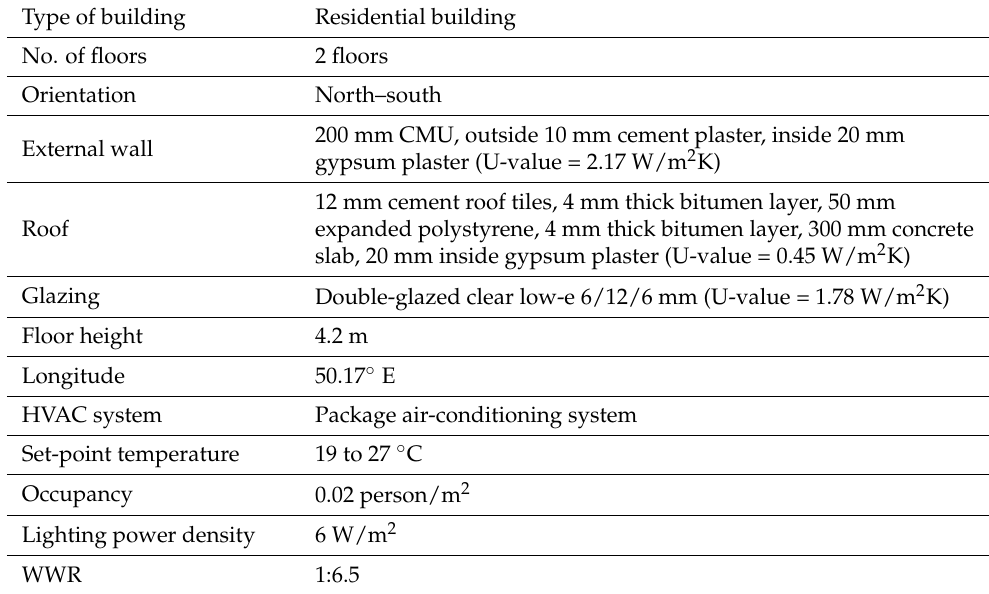
Figure 2. 3D model layout of the building in IES-VE. Table 1. Physical and functional properties of the building.